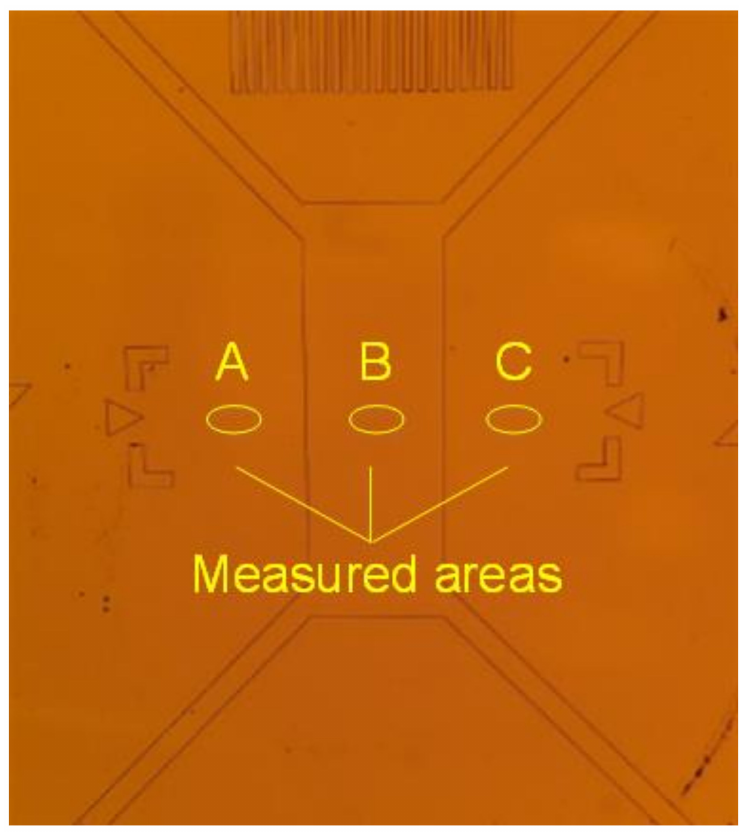
Figure 9. Micrograph of SHS-4.5QC (A, B, C are the areas to be measured). Due to the large size of the measured step, it is difficult to measure the complete structure. Therefore, the method of sectional measurement in this paper is used to measure the A, B, and C positions of the step structure, as shown in Figure 10. Then, the measurement results are spliced and evaluated using the method defined in ISO5436-1.